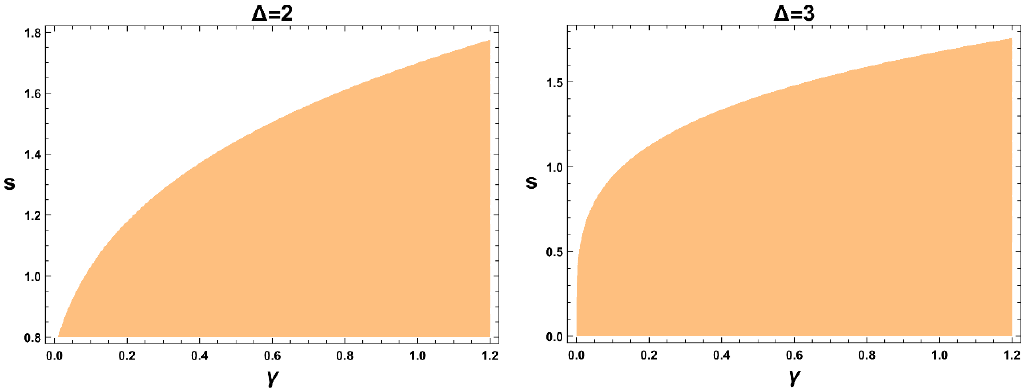
Figure 1 . Instability of the Z 2 symmetric phase (the green region) of the holographic viscoelastic media for the choice of parameters (3.1), see (3.6).